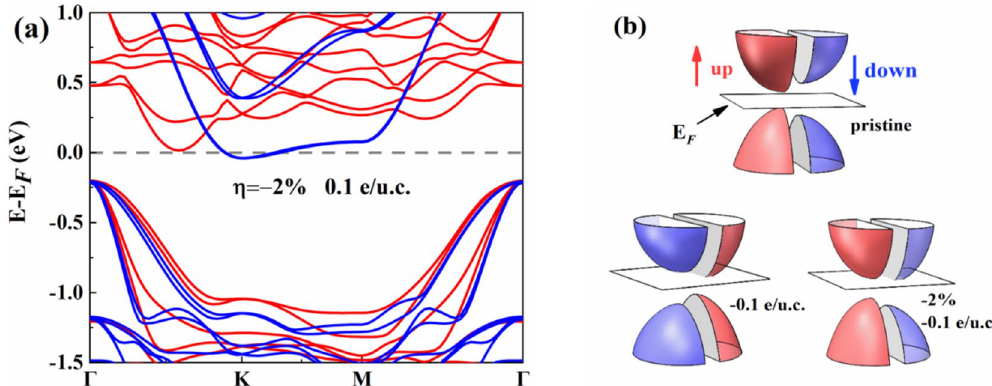
Figure 5. ( a ) The band structure of bilayer Cr 2 Ge 2 Te 6 under dual regulations (compressive strain of 2% and electron doping of 0.1 e/u.c.). Horizontal dashed lines denote the Fermi level. ( b ) The schematic of the electronic structures restructuring models under the electron doping (− 0.1 e/u.c.) or dual regulations. Spin-up and spin- down states are marked by red and blue, respectively. The white plane denotes the Fermi